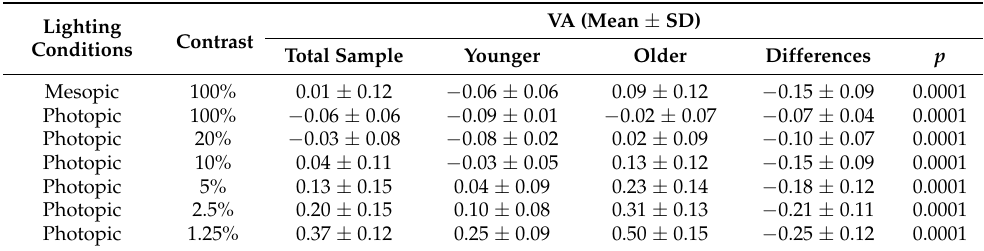
Table 2. Visual Acuity of the total sample and by ages in different lighting conditions and with different contrast.